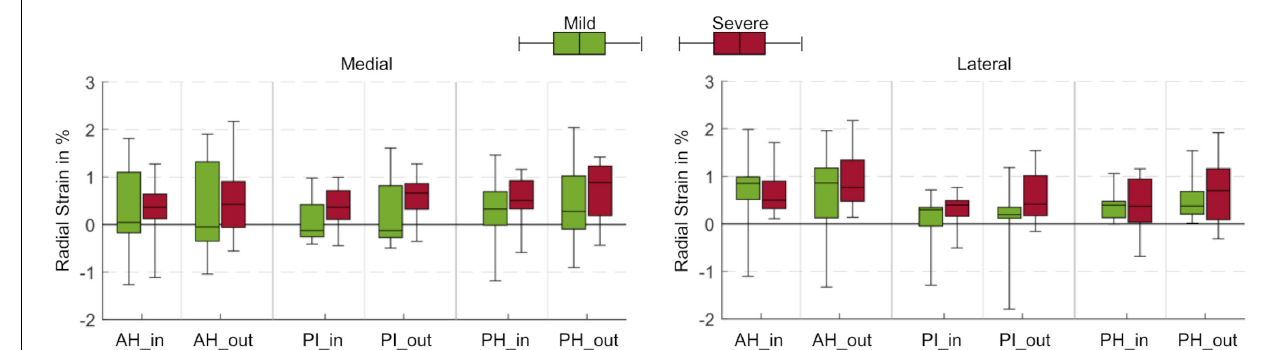
FIGURE 4 | Box plots (maximum, minimum, median, 25–75 percentile values) of radial strains at a load level of 100% body weight in percent for mild (green) and severe (red) degenerated knee joints. Three anatomic regions of the medial and lateral meniscus (AH = anterior horn; PI = pars intermedia; PH = posterior horn) were each subdivided into an inner (_in) and outer (_out) circumference. No statistically significant differences were found ( p > 0.05).